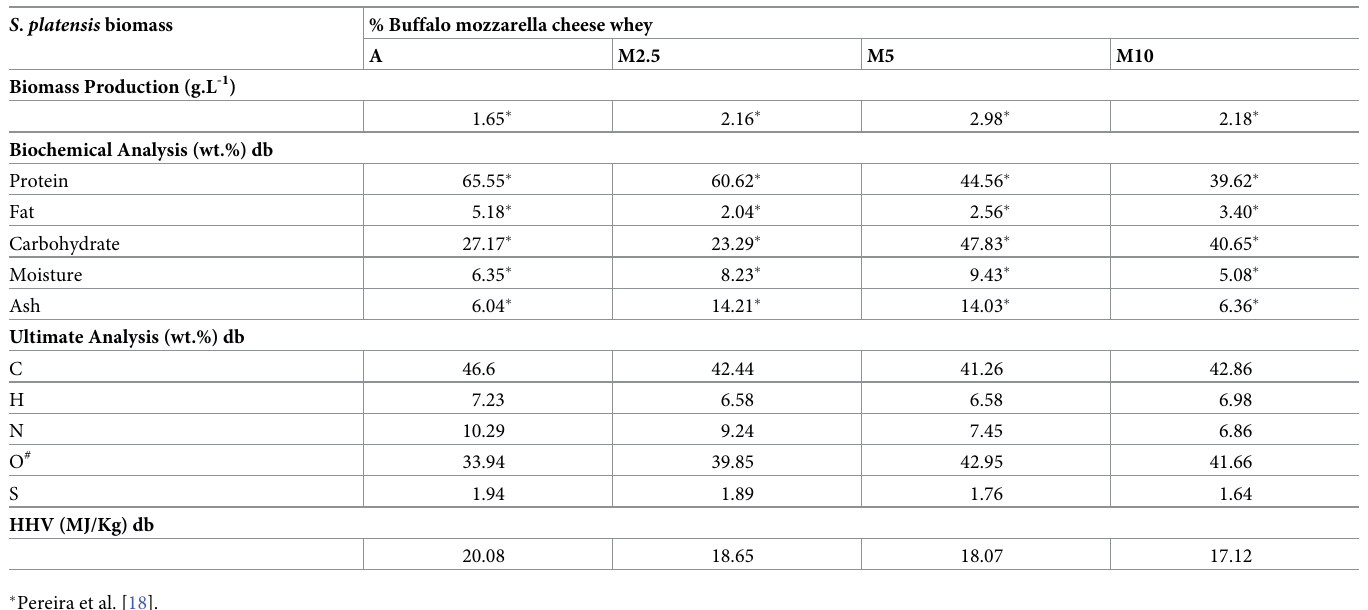
Table 2. Characteristics of S . platensis